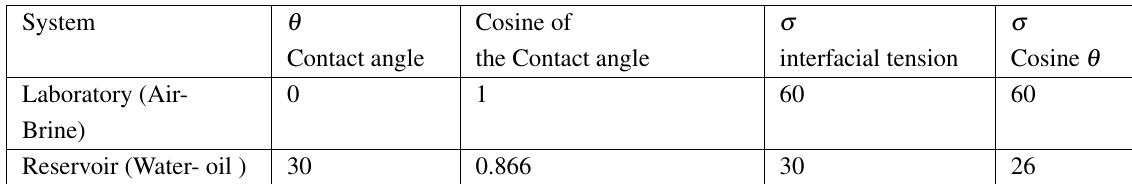
Table 4. Approximation values of contact angle and interfacialtension